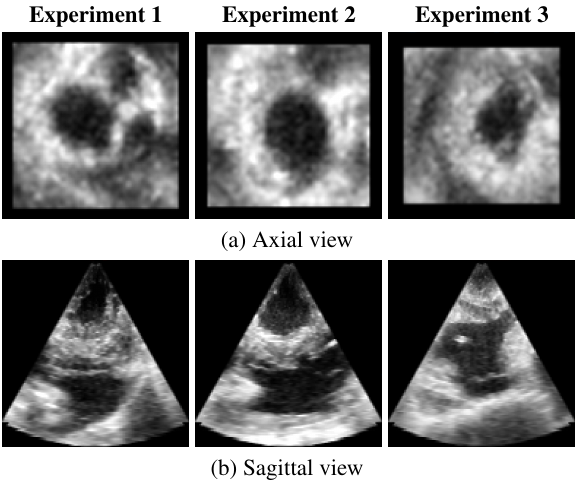
Figure 2. Examples of the source three-dimensional dataset with empty heart